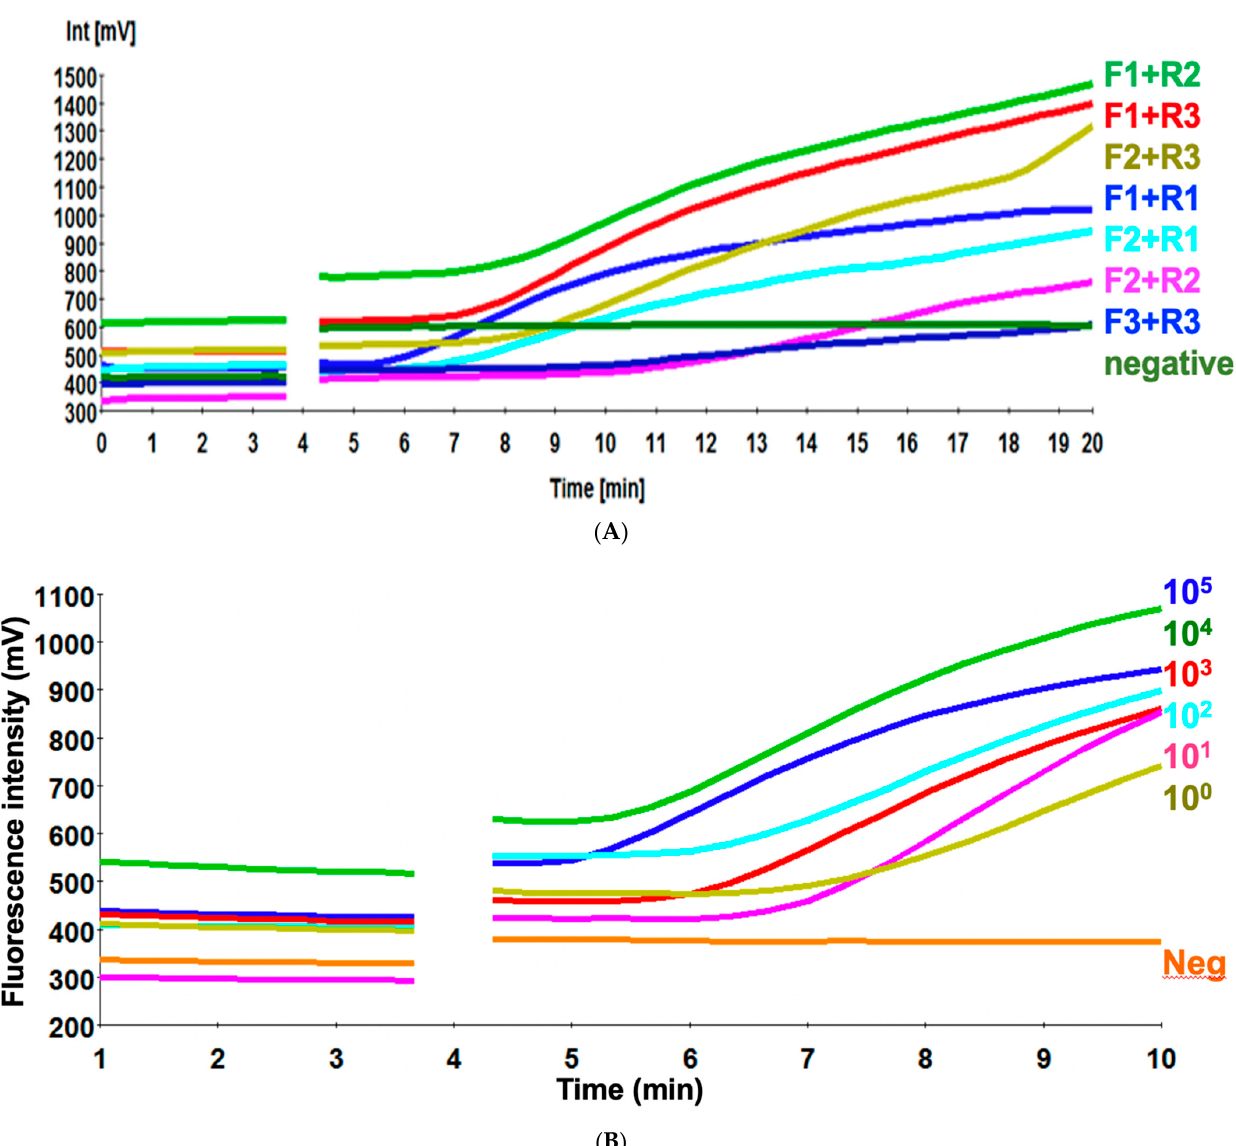
Figure 1. Primer combination testing using 10 5 EID 50 per RT-RPA reaction mixture ( A ). Analytical sensitivity of H9 RT-RPA using standard virus of titer 10 5 EID 50 /mL using a dilution range down to 1 EID 50 /mL ( B ). The combination H9 RPA-F1+ H9 RPA-R1+ H9 exo-probe was detected down to one RNA molecule. The discontinuity at 3 min 50 s due to the necessary mixing step interrupting fluorescence measurement.